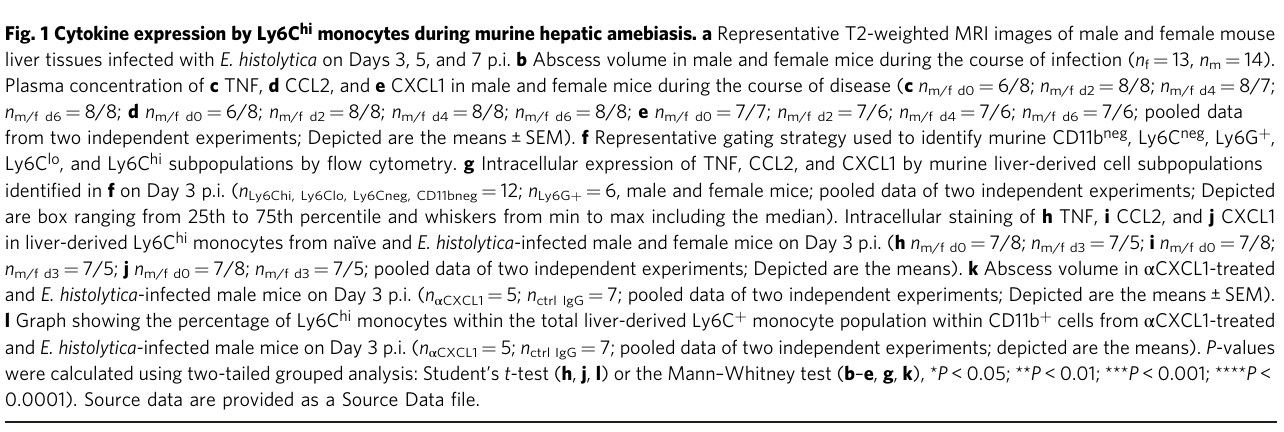
Fig. 1 Cytokine expression by Ly6C hi monocytes during murine hepatic amebiasis. a Representative T2-weighted MRI images of male and female mouse liver tissues infected with E. histolytica on Days 3, 5, and 7 p.i. b Abscess volume in male and female mice during the course of infection ( n f = 13, n m = 14). Plasma concentration of c TNF, d CCL2, and e CXCL1 in male and female mice during the course of disease ( c n m/f d0 = 6/8; n m/f d2 = 8/8; n m/f d4 = 8/7; n = 8/8; d n = 6/8; n = 8/8; n = 8/8; n = 8/8; e n = 7/7; n = 7/6; n = 7/6; n = 7/6; pooled data m/f d6 m/f d0 m/f d2 m/f d4 m/f d6 m/f d0 m/f d2 m/f d4 m/f d6 from two independent experiments; Depicted are the means ± SEM). f Representative gating strategy used to identify murine CD11b neg , Ly6C neg , Ly6G +